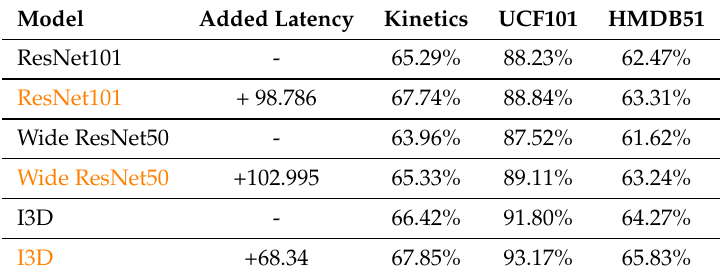
Table 3. Direct comparison of architectures with (in orange) and without (in black) Class Regularization blocks. Latency in